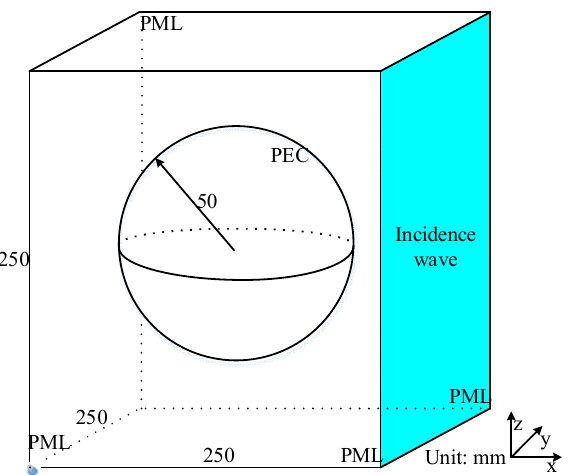
Figure 9. The sketch picture of the metal sphere model inside the entire computational domain.